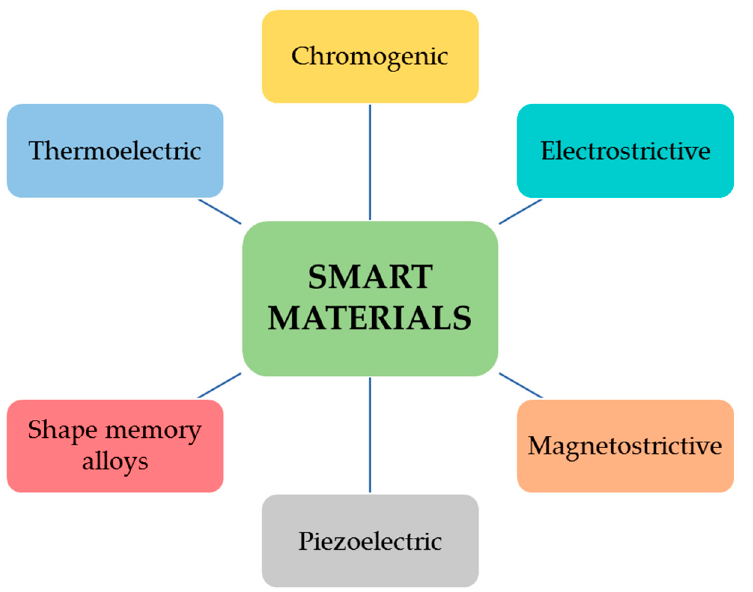
Figure 1. Classification of smart materials [4]. Reprinted from “Polymer Nanocomposite-Based Smart Materials”, edit by: Rachid Bouhfid, Abou el Kacem Qaiss, Mohammad Jawaid, in